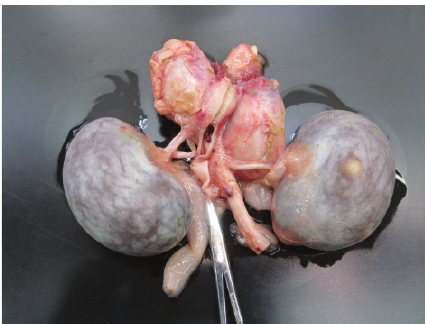
Figure2:Grossimageofkidneysandtumormasses.Tumornodules are present between the kidneys in the region of the adrenal glands and renal lymph nodes and also within the caudal vena cave (asterisk). The left kidney has a small tumor nodule underneath the capsule. Top: cranial, bottom: caudal. The ruler spans